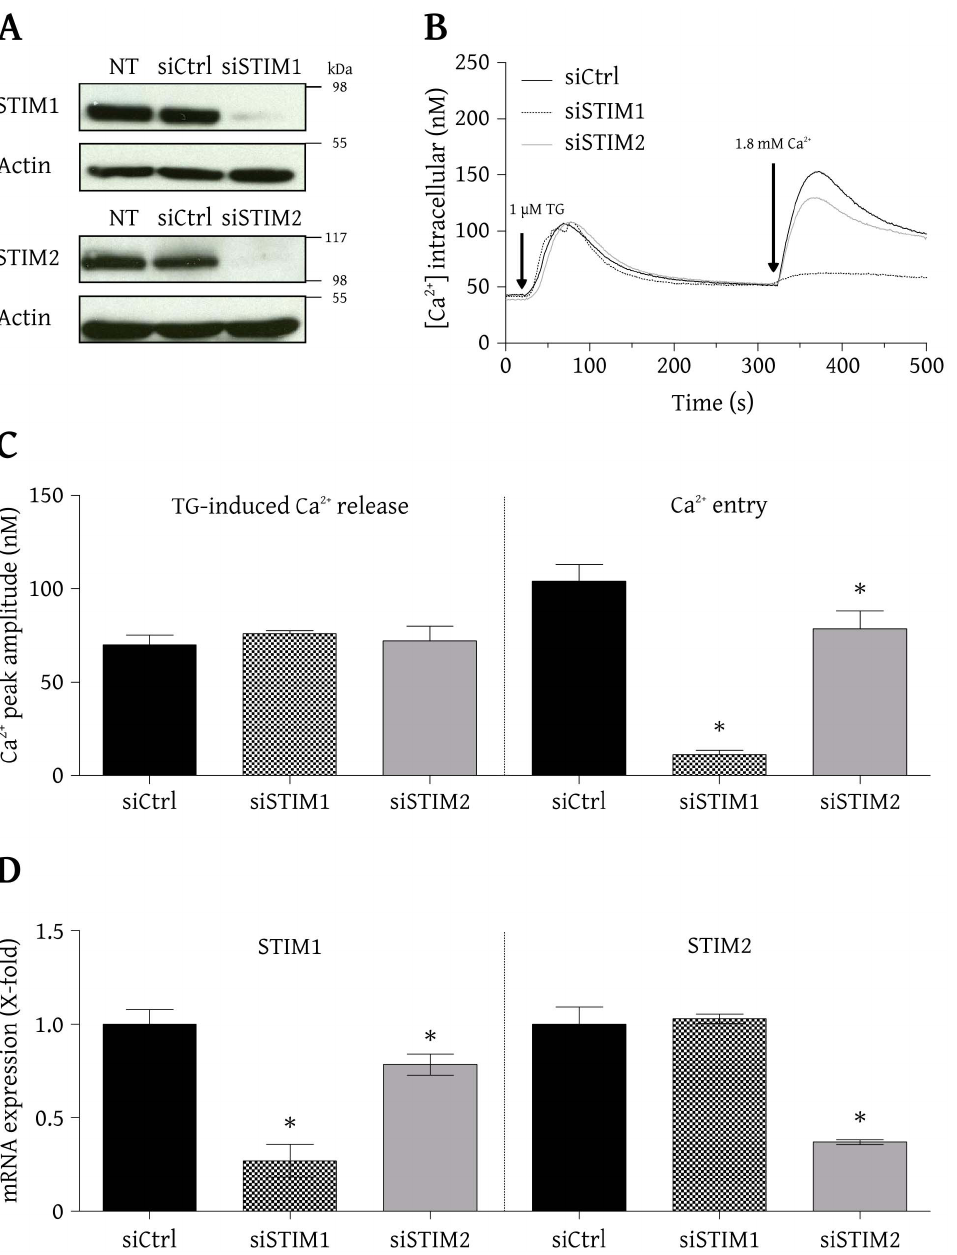
Fig. 1. STIM1 and STIM2 are expressed in BAECs and contribute to SOCE. A) Cells were transfected with siCtrl, siSTIM1 or siSTIM2. After 48 h, cells were lysed and proteins were resolved by SDS-PAGE and identified by Western blot using selective antibodies against STIM1, STIM2 or actin (NT indicates non transfected cells). B) BAECs were loaded with fura-2/AM and imaged using an Olympus IX71 microscope (40 6 oil immersion objective) coupled to a MetaFluor imaging system for the recording of the intracellular Ca 2 + concentration. In a nominally free Ca 2 + medium, cells were treated with 1 m M TG to deplete their Ca 2 + store and, once the Ca 2 + concentration had stabilized, 1.8 mM Ca 2 + was added to the medium to induce Ca 2 + entry. The figure shows average traces from cells ( . 75 cells/condition) transfected with siCtrl (black line), siSTIM1 (dashed line) or siSTIM2 (gray line). C) Average Ca 2 + increase (peak amplitude) after treatment with TG and subsequent Ca 2 + entry (mean ¡ SD of results obtained from 3–4 independent experiments, * p , 0.05). D) Total RNA was extracted from transfected cells (48 h post-transfection) and subjected to a qPCR analysis using specific primers for STIM1 and STIM2 to evaluate their relative level of encoding mRNAs. The results represent the mean ¡ SD of three independent experiments.